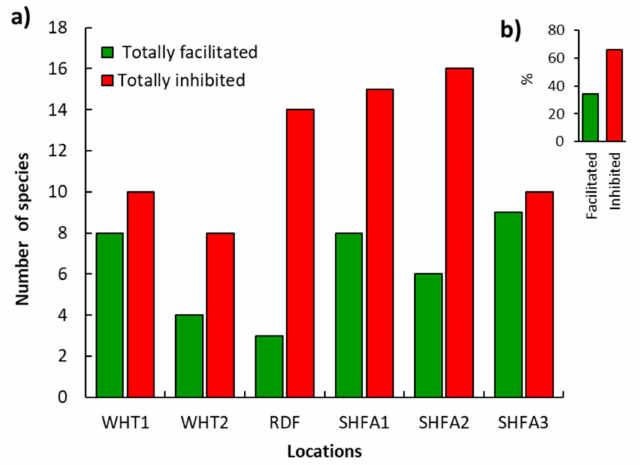
Figure 6. The recorded plant species under the canopy of Nicotiana glauca (facilitated) and outside the canopy (inhibited) in different locations at the Taif region, western Saudi Arabia ( a ), and the average percentage of all locations ( b ).